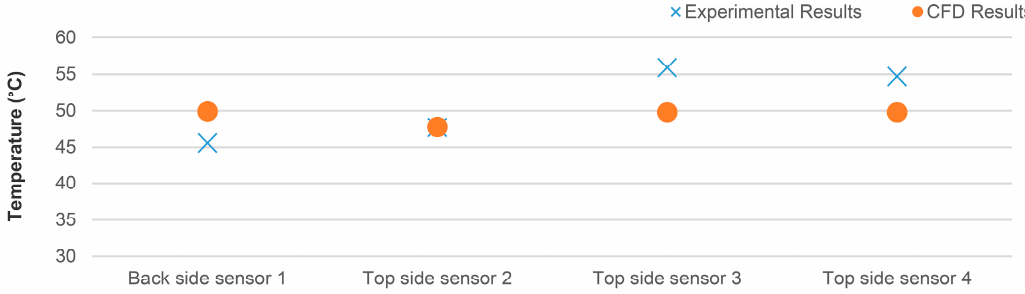
Figure 15. Measurement B: experimental results versus CFD results .